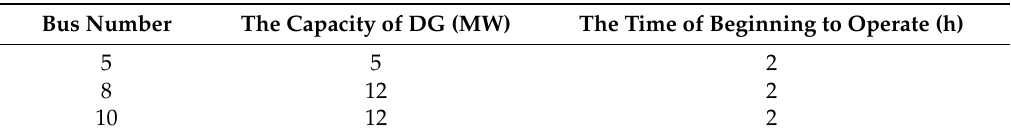
Table 10. The Information of DGs on important